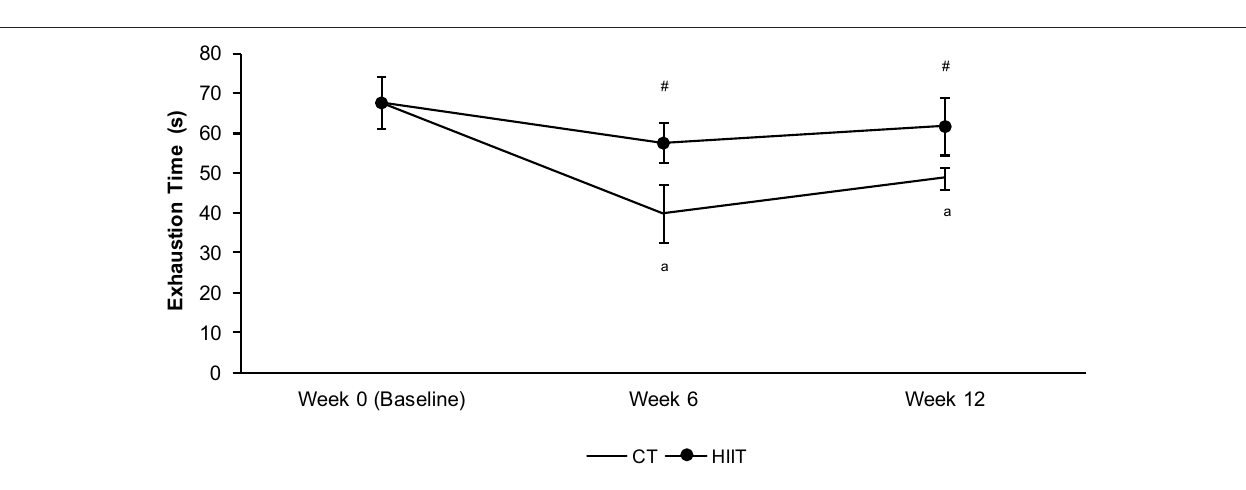
than CT 6 weeks and baseline. HIIT long term (12 weeks) reduced the corticosterone concentration in relation to CT 12 weeks and baseline ( Table 1